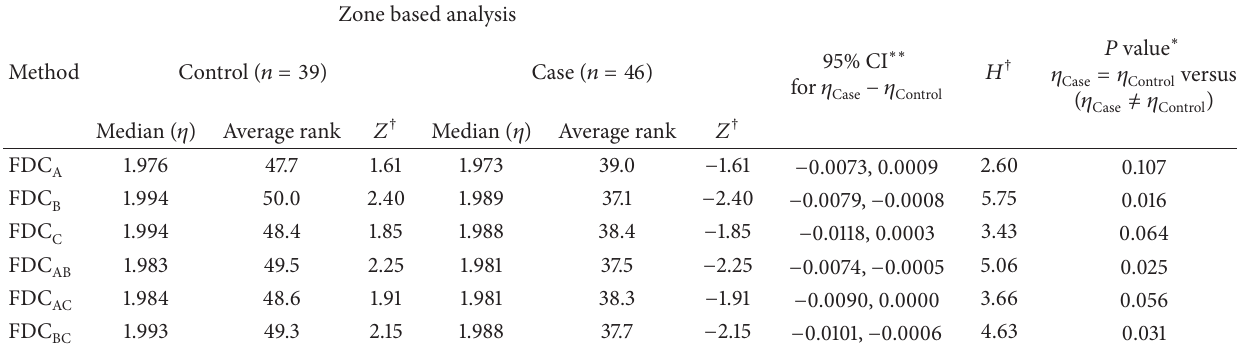
Table 3: Kruskal-Wallis and Mann-Whitney zone based FDC significance